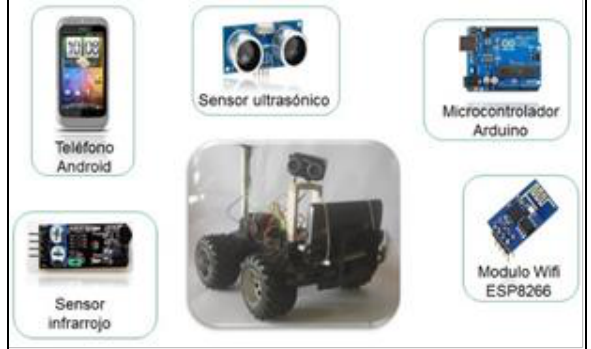
Figura 3: Plataforma robótica móvil. Fuente: Los autores, (2018).